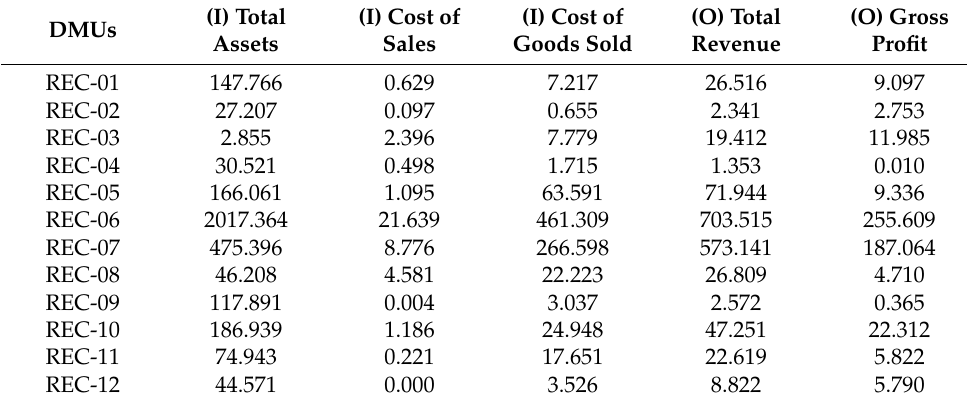
Table A7. The predictive data of the year 2021, (unit: million USD).